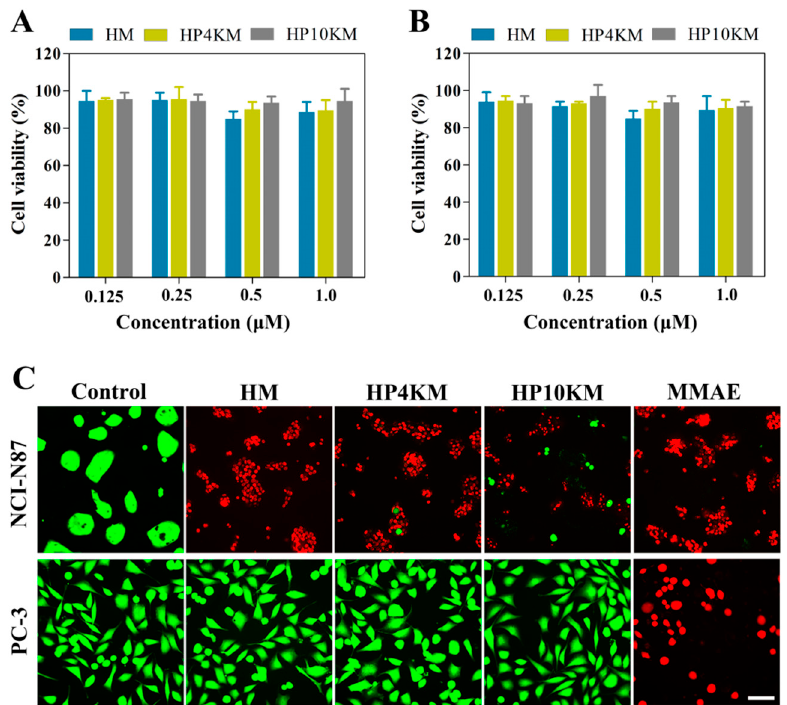
Figure 4. Competitive inhibition assay and live/dead staining imaging for detection of the cytotoxicity of the conjugates. NCI-N87 cells ( A ) and BT-474 cells ( B ) were preincubated with the affibody Z HER2:2891 (5 μ M) for 2 h before the conjugates were added, and the cell viability was determined by in vitro cytotoxicity assays. ( C ) NCI-N87 cells and PC-3 cells were incubated with 200 nM of the conjugates for 72 h and then visualized by microscopy imaging. Scale bars, 20 μ